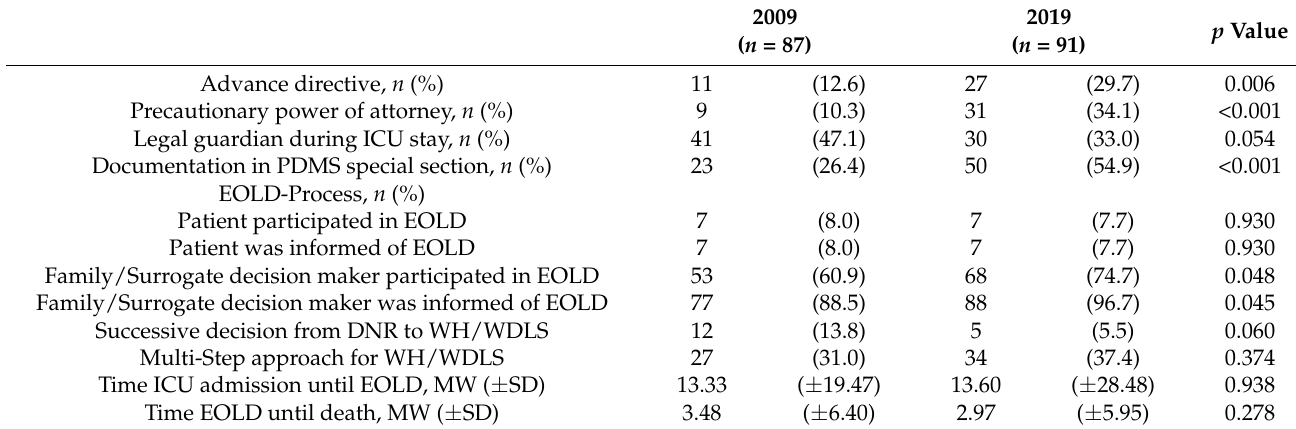
Table 4. Prevalence of advance directives and the EOLD process in patients deceased with